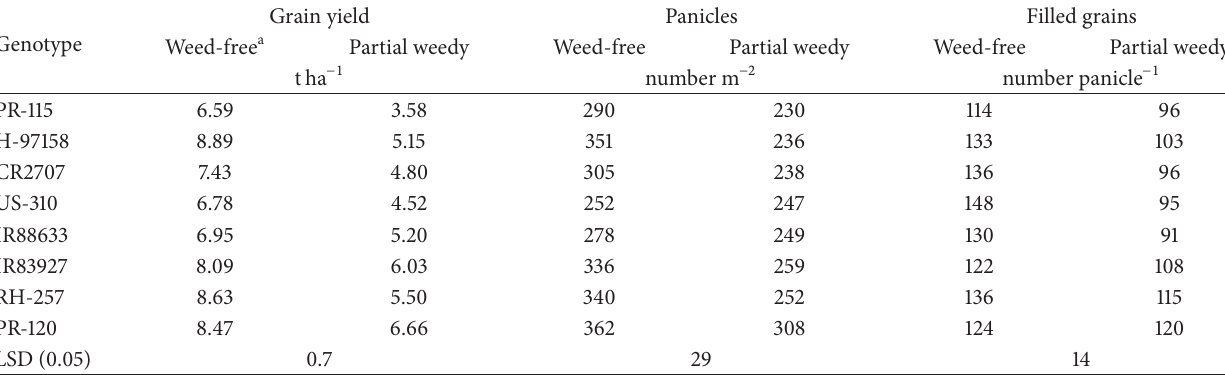
Table 3: Grain yield (tha −1 ), panicles m −2 and grains panicle −1 in response to the interaction effect of weed infestation levels and genotypes. Grain yield Panicles Filled grains Genotype Weed-free a Partial weedy Weed-free Partial weedy Weed-free Partial weedy tha −1 number m −2 number panicle −1